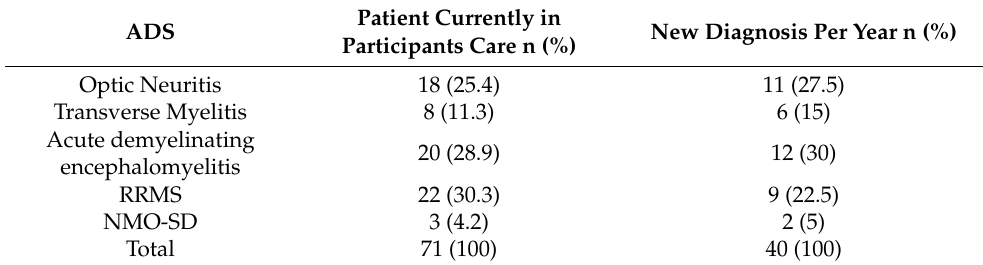
Table 1. Frequency of distinct acute demyelinating